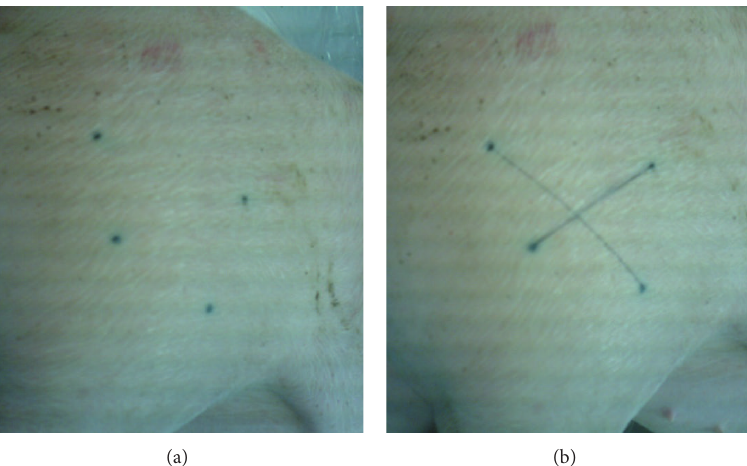
Figure 1: Identification of the injection point. (a) Four dots were tattooed with Indian ink on the skin of the left biceps femoris muscle 2 to 3 weeks before the injection. (b) The injection site of the plasmids was located at the intersection of the two lines passing through these dots. These two lines were drawn on the skin just before the